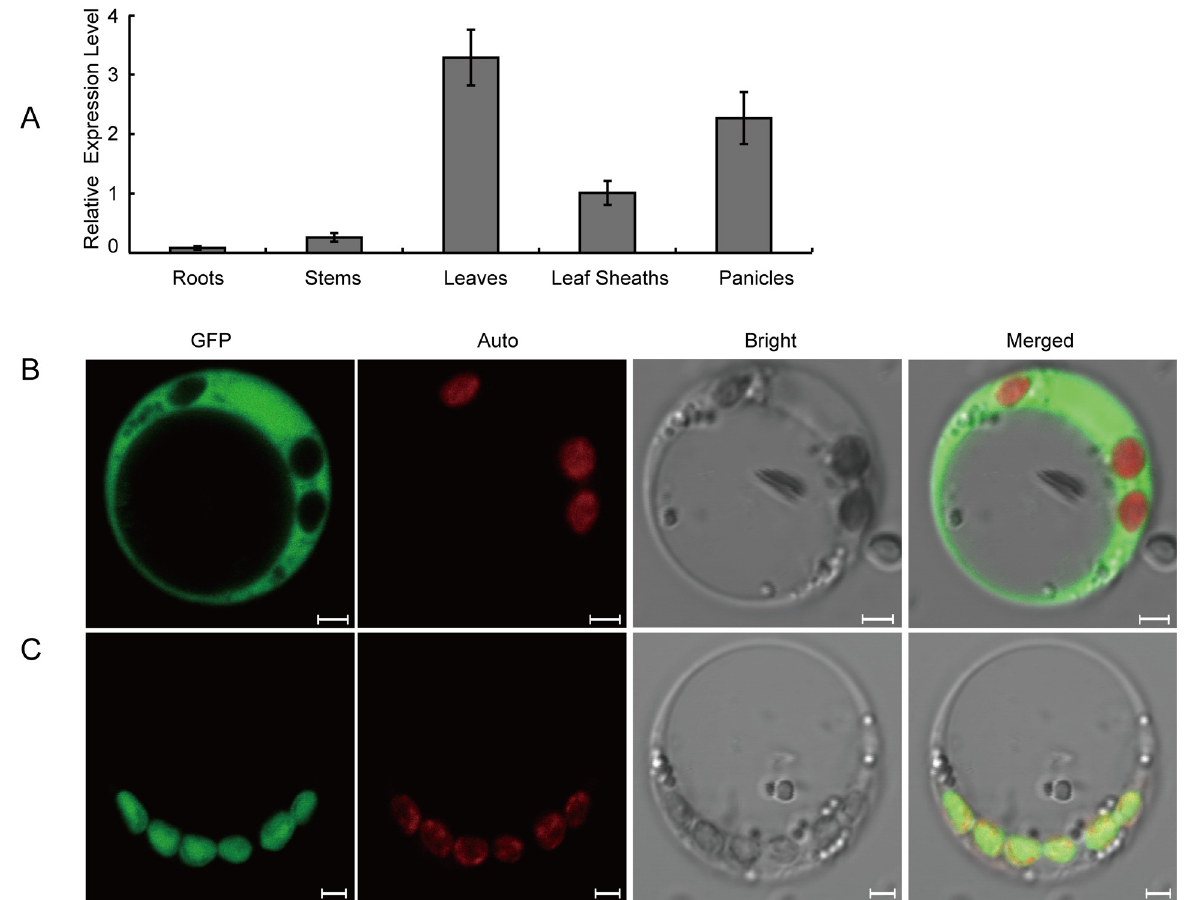
Fig 7. Expression of OscpSRP43 and subcellular localization of OscpSRP43. A, Relative expression of OscpSRP43 in different organs of the wild type IR64 at the heading stage; B, Transient expression of GFP protein in rice protoplasts; C, Transient expression of OscpSRP43:GFP fusion protein in rice protoplasts; GFP, green fluorescence protein and OscpSRP43:GFP fusion protein; Auto, Chl auto fluorescence; Bright, bright field; Merged, merged image of GFP, Auto and